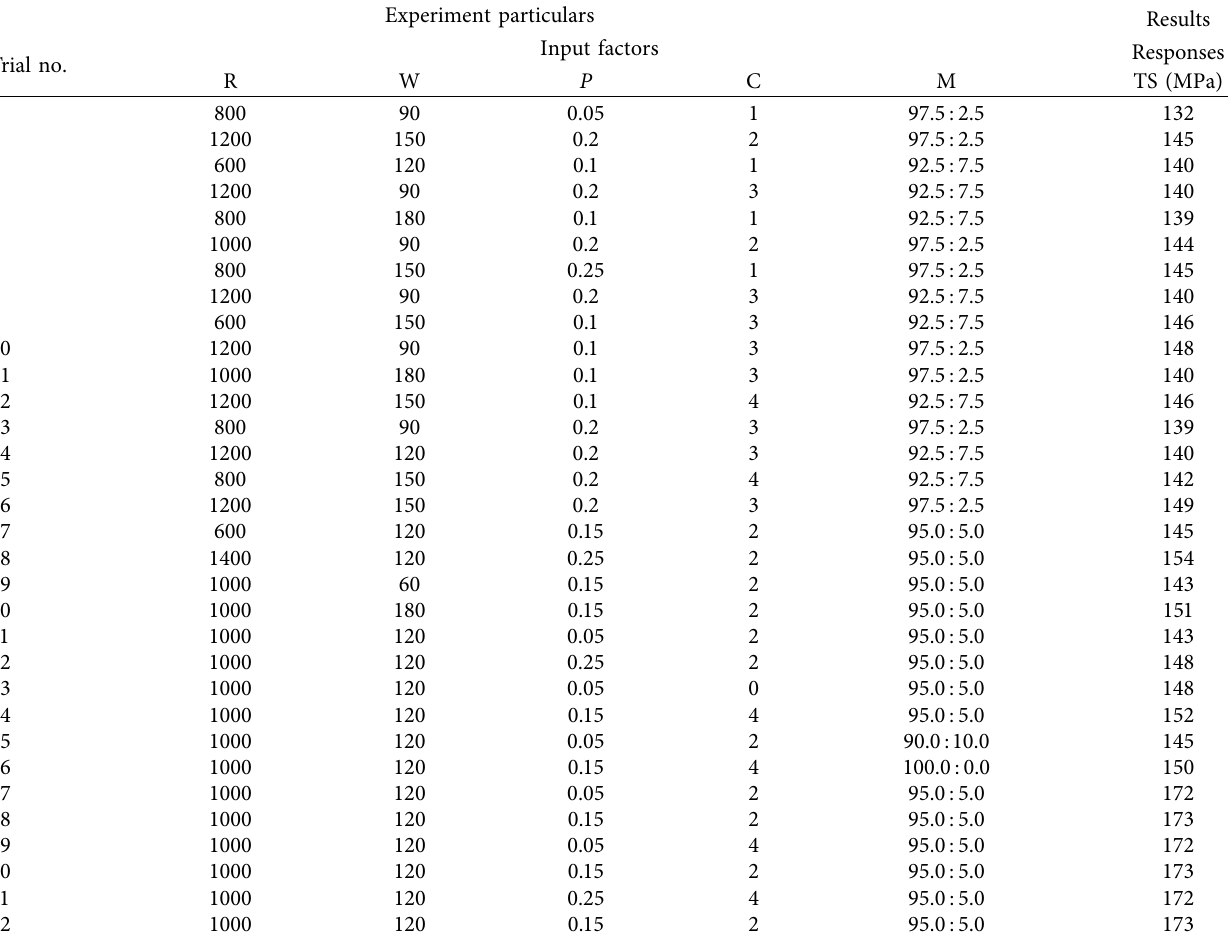
Table 5: Design matrix for tensile